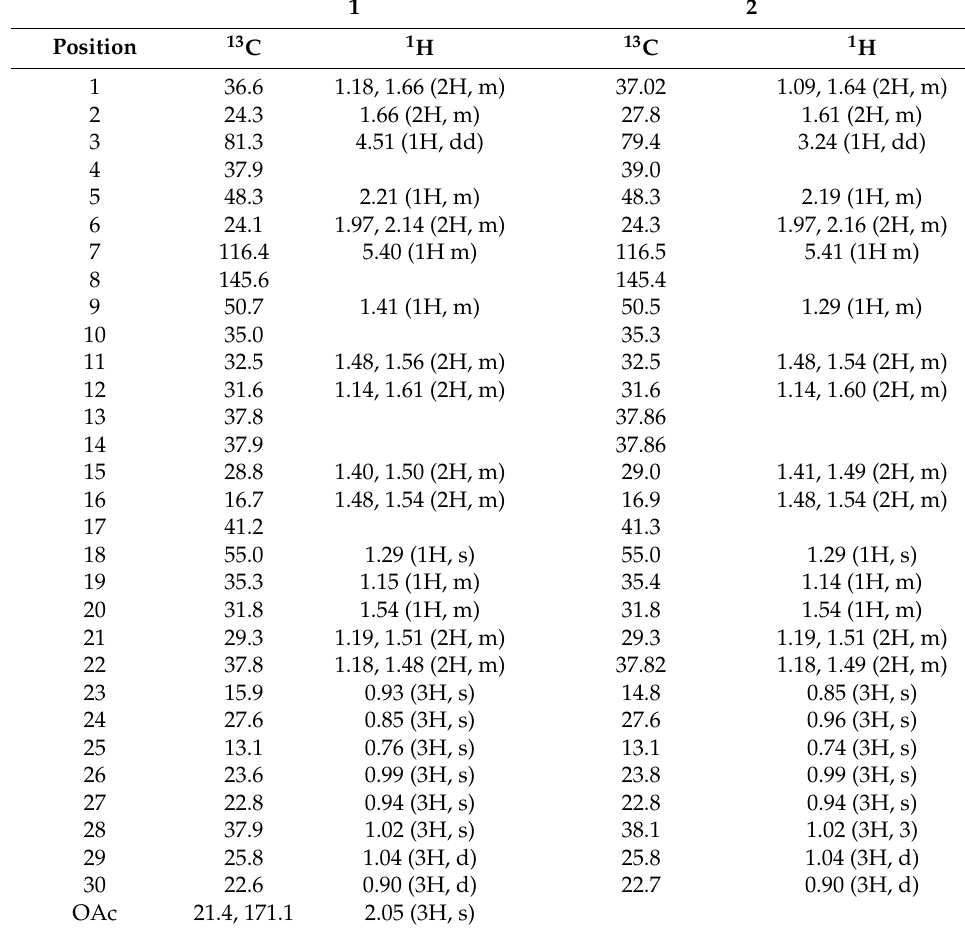
Table 1. 1 H- and 13 C-NMR Spectra Data for 1 and 2